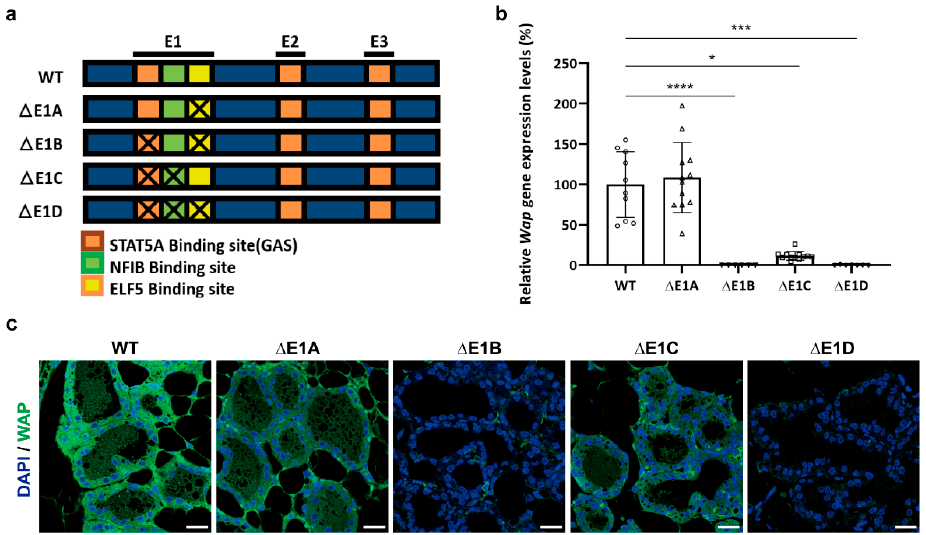
Figure 4. Expression of the Wap gene in E1-mutant mice. ( a ) Schematic depiction of CRISPR-Cas9- targeted mice. ( b ) Relative expression levels of the Wap gene in E1-mutant mice at L1. Wap mRNA levels were measured by RT-qPCR and normalized to Gapdh levels. Data are presented as means ± SD of different donor mice for each mouse line (* p < 0.05; *** p < 0.001; **** p < 0.0001). WT, n = 10; Δ E1A, n = 12; Δ E1B, n = 6; Δ E1C, n = 12; Δ E1D, n = 7. A circle, WT; a triangle, Δ E1A; an inverted triangle, Δ E1B; a square; Δ E1C; a diamond, Δ E1D ( c ) Immunofluorescence images of WAP expres- sion in L1 mammary tissues of mutant mice. WAP is shown in green, and DAPI-stained cell nuclei are shown in blue. Representative images from three different donor mice for each mouse line are shown. Magnification, 400×; scale bar, 20 μ M.